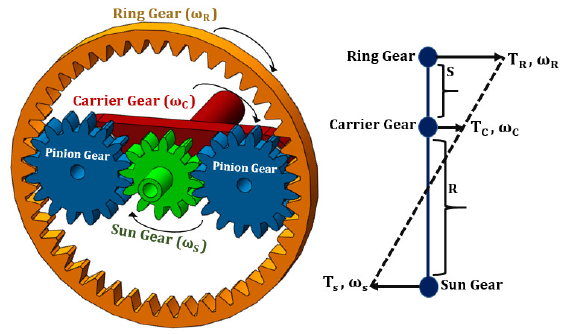
Figure 1. Three-dimensional representation of a planetary gearbox with its lever analogy.